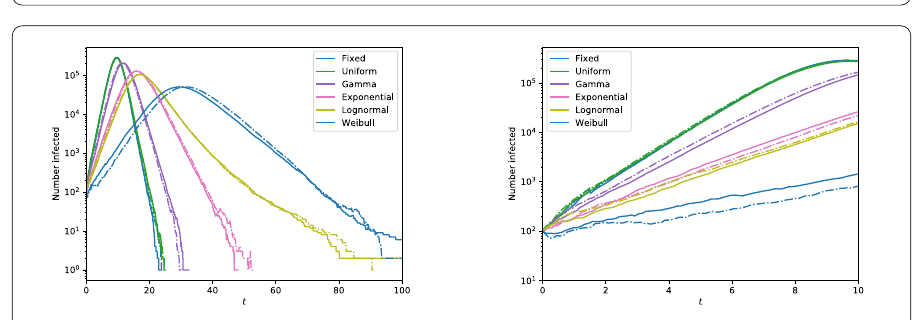
Figure 2 Dynamics of epidemics in regular network. Taking τ = 0.15, we show two epidemic curves for each distribution from Fig. 1. On the right we see the early dynamics